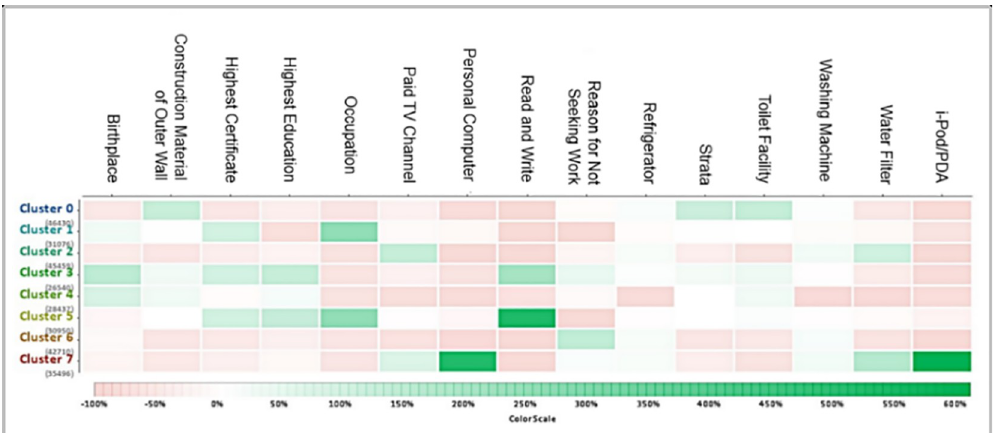
Fig 5. List of important attributes for B40 clustering model from heat map